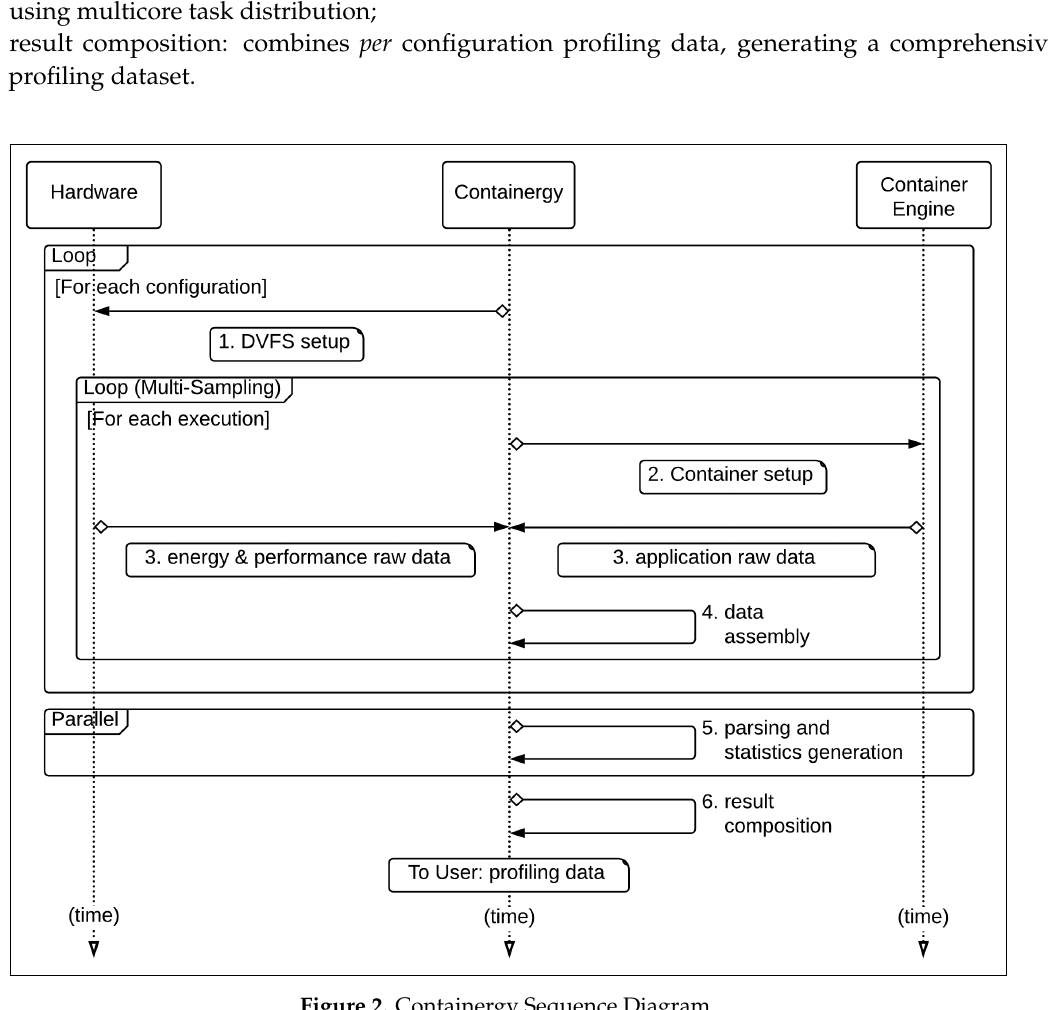
Figure 2. Containergy Sequence